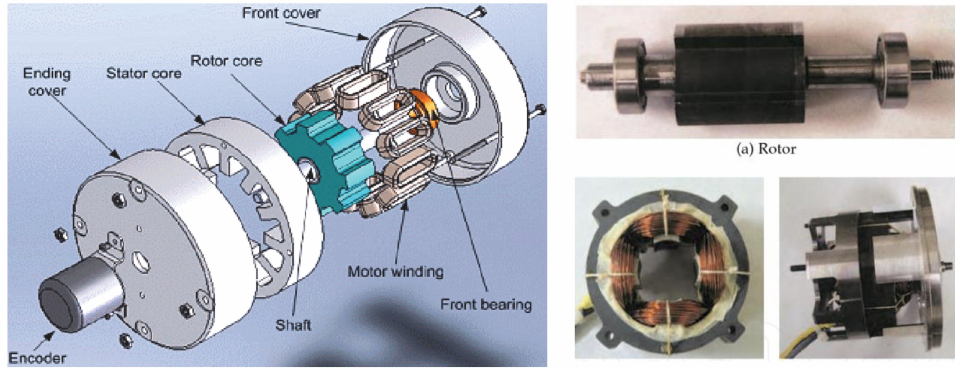
Figure 7. Switched reluctance motor for flywheel adapted from [85].